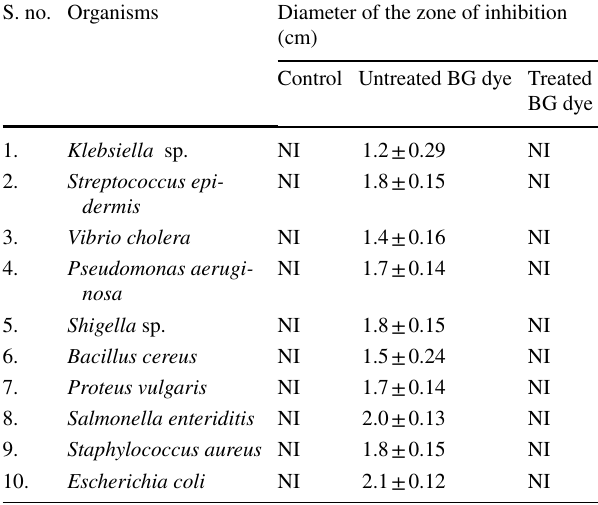
Table 1 Bacterial toxicity of the untreated and treated dye